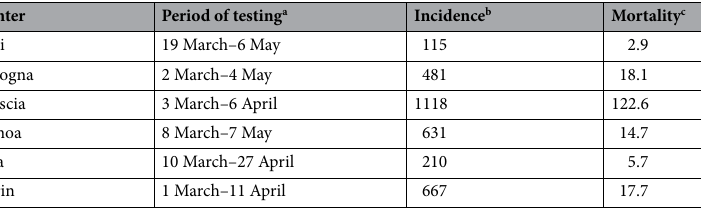
Table 1. Selected characteristics of surveillance programs and occurrence of COVID-19, by center. a Period included in the analysis. b Cumulative incidence of COVID-19/100,000 in the study areas during